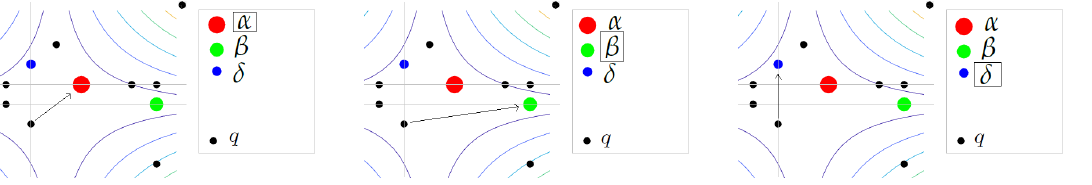
Figure 9. Discrete GWO: displacement of an agent q towards a leader, either α , β , or δ , selected at